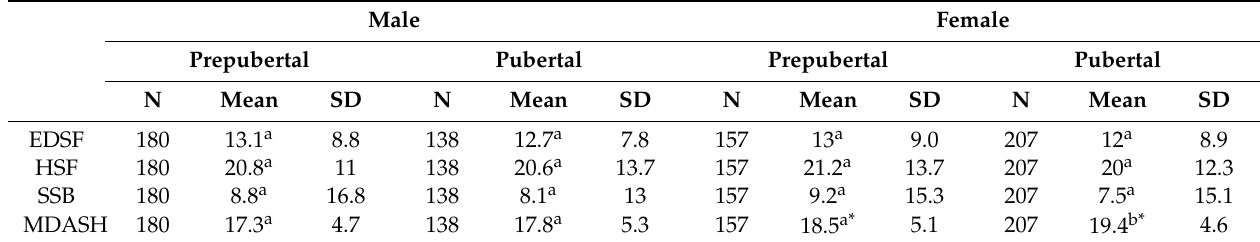
Table 1. Food group consumption according to sex and pubertal stage.